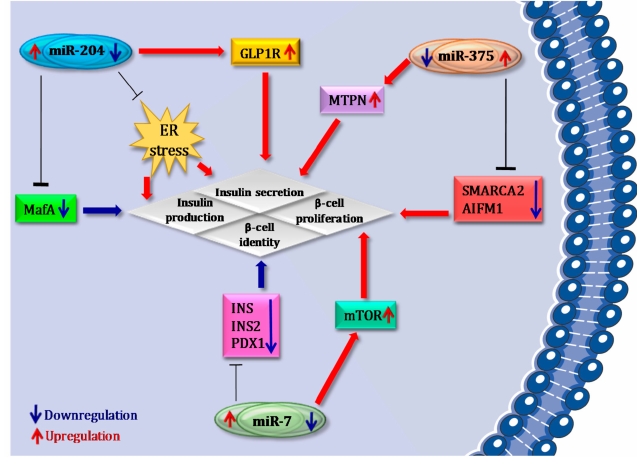
Figure 2. MicroRNAs in β cell identity and function. Several miRNAs regulate β cell identity and function. Hyperexpression of miR-204 induced by TXNIP causes suppression of insulin production by directly targeting and downregulating MafA ; on the other hand, reduction of miR-204 induces GLP1R upregulation, thus resulting in an improvement in insulin secretion. Genetic deletion of miR-204 protects β cells from ER stress-induced apoptosis, thus leading to improved insulin secretion. Importantly, miR-375 hyperexpression is able to stimulate β cell proliferation, mainly by inhibiting anti-proliferative genes such as Smarca2 and Aifm1 , while selective inhibition of miR-375 leads to upregulation of MTPN , thus improving glucose-stimulated insulin secretion. Another miRNA involved in β cell proliferation is miR-7. Indeed, its downregulation is able to induce hyperexpression and the subsequent activation of mTOR pathway, leading to β cell replication. On the contrary, transgenic hyperexpression of miR-7 in murine pancreatic islets leads to loss of β cell identity by inhibiting the expression of Ins1 , Ins2 , Pdx1 and other genes involved in the maintenance of β cell